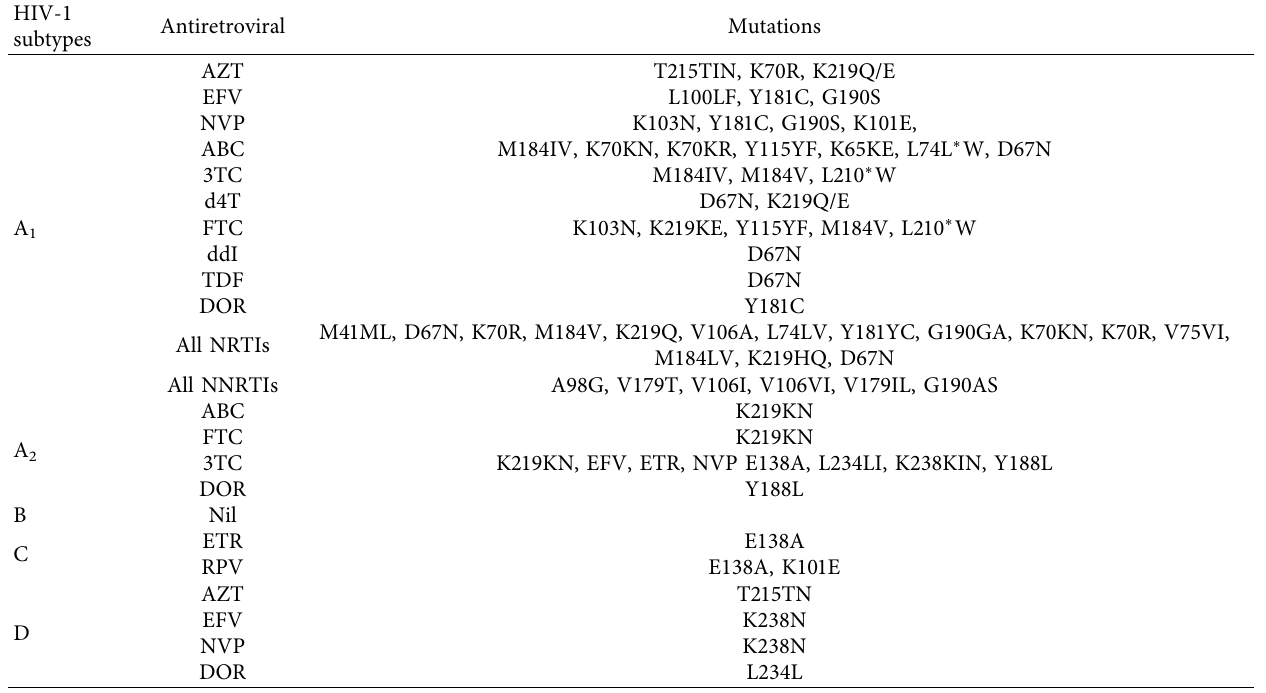
Table 4: Drug-resistant mutations circulating among HIV-1 subtypes.